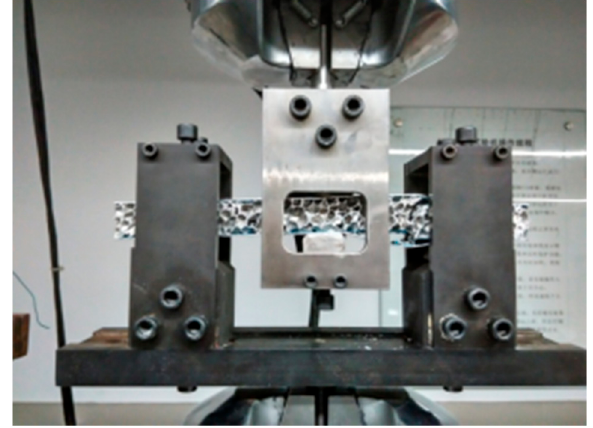
Figure 2. Loading diagram of sample and fixture for fatigue test.